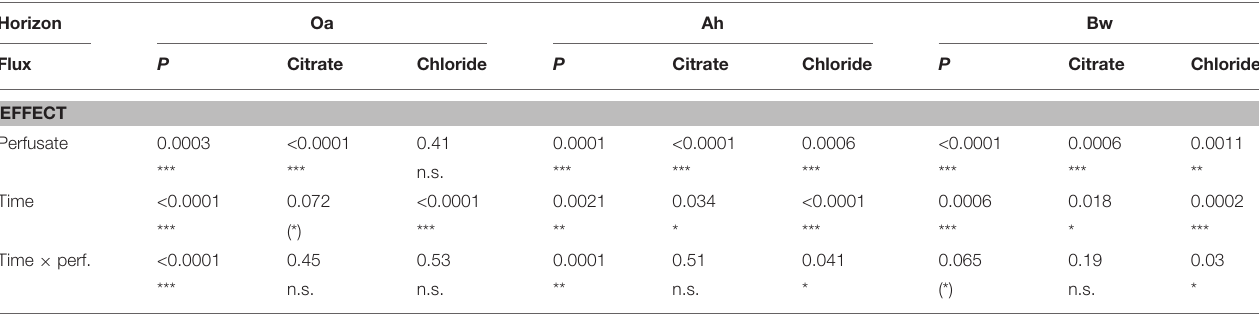
TABLE 3 | Comparison of fluxes reported in Figure 2 : p -values of the robust 2-way mixed anova considering within-subject effects (repeated measurement of probes over time) and between-subject effects (perfusates). Horizon Oa Ah Bw Flux P Citrate Chloride P Citrate Chloride P Citrate Chloride